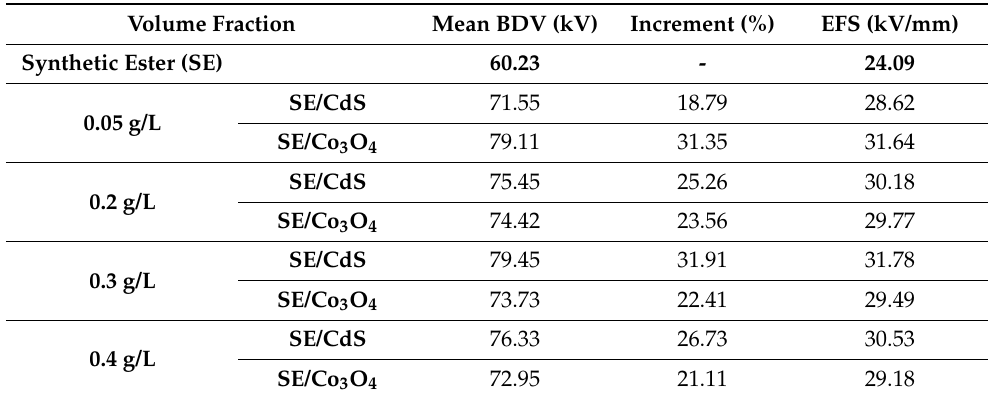
Table 2. This mean AC breakdown voltage (AC BDV) and electric field strength (EFS) of synthetic ester (SE) and